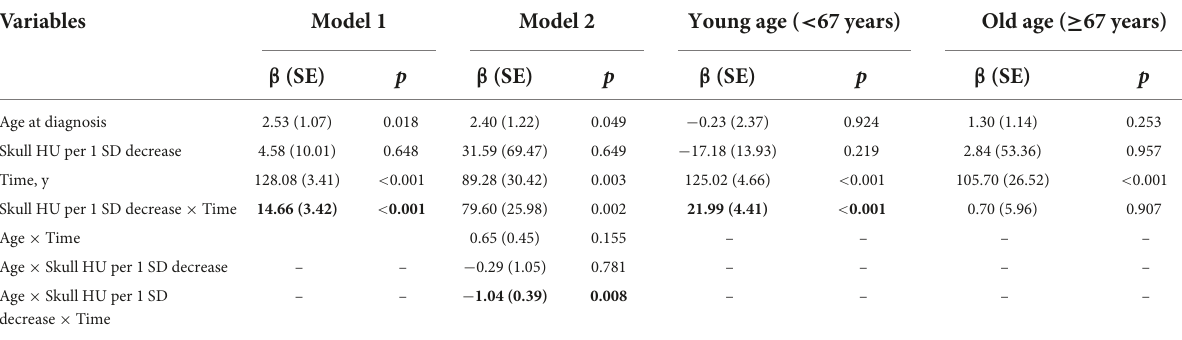
TABLE 5 Longitudinal changes of levodopa-equivalent